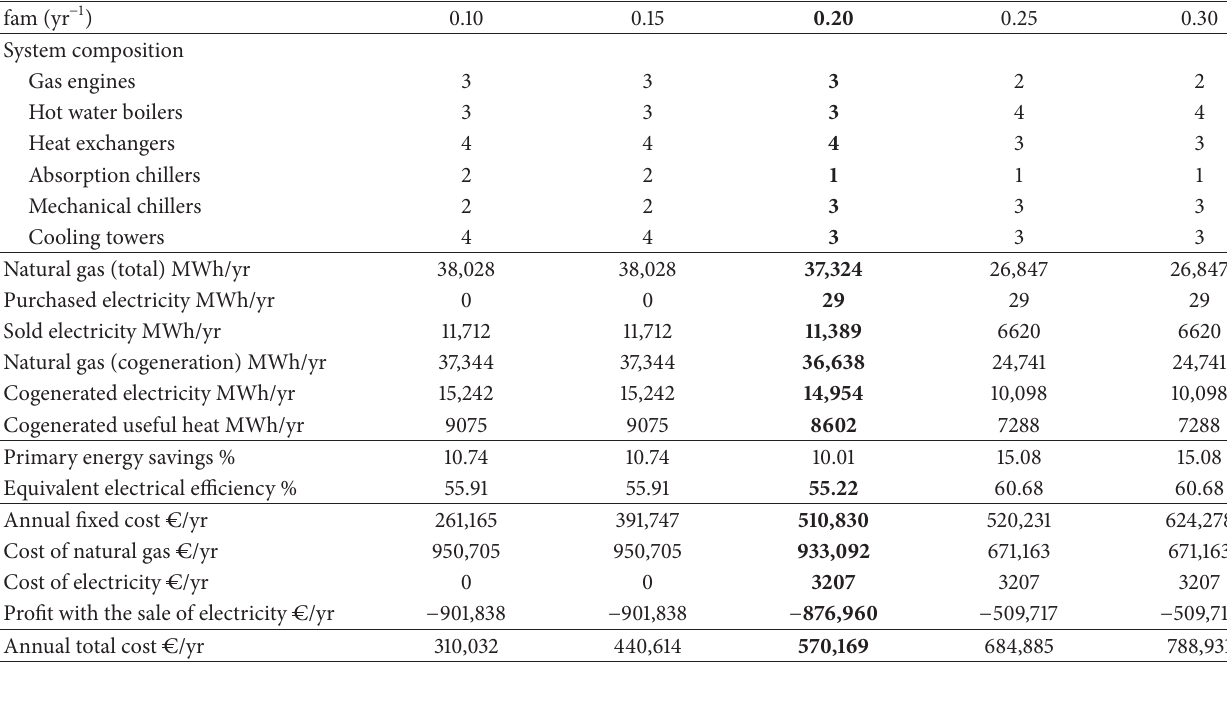
Table 5: Sensitivity analysis for fam factor.